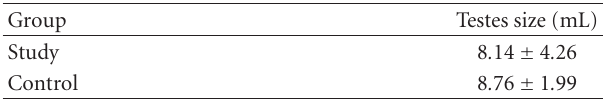
Table 3: Preoperative average serum testosterone levels in study and control groups.